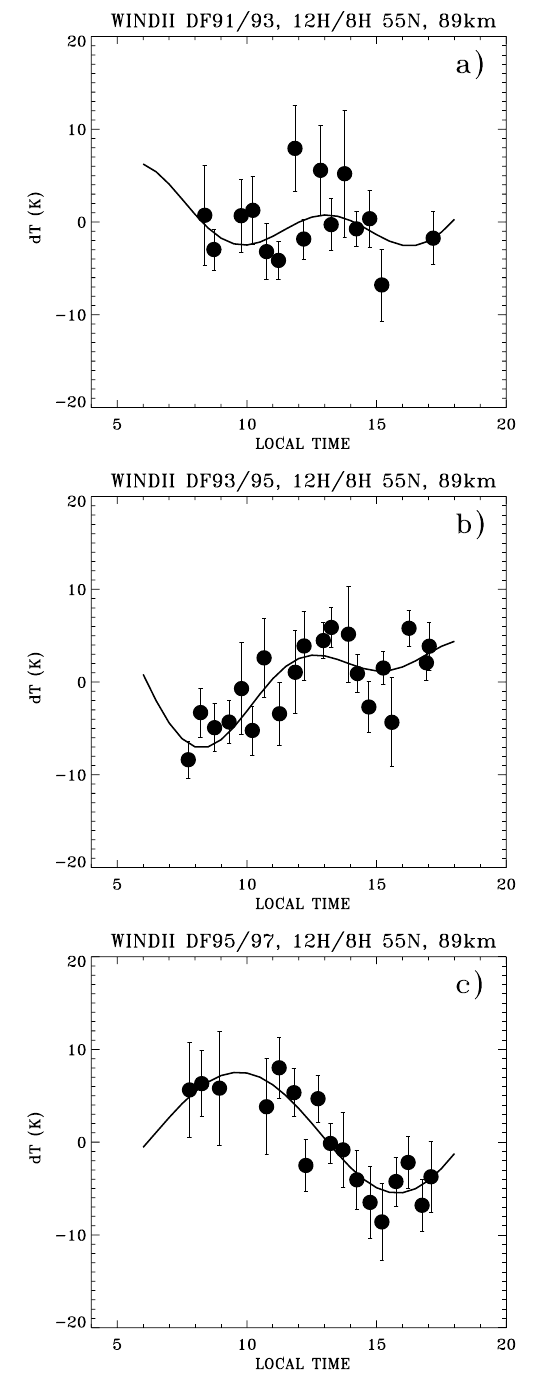
Fig. 1. WINDII temperature semidiurnal and terdiurnal tidal fits at 55 ◦ N and 89km height for winter solstice (December, January, and February). The temperature data are two-year composites from 1991 to 1997 fitted simultaneously to 12-h and 8-h tidal harmonics (solid line).